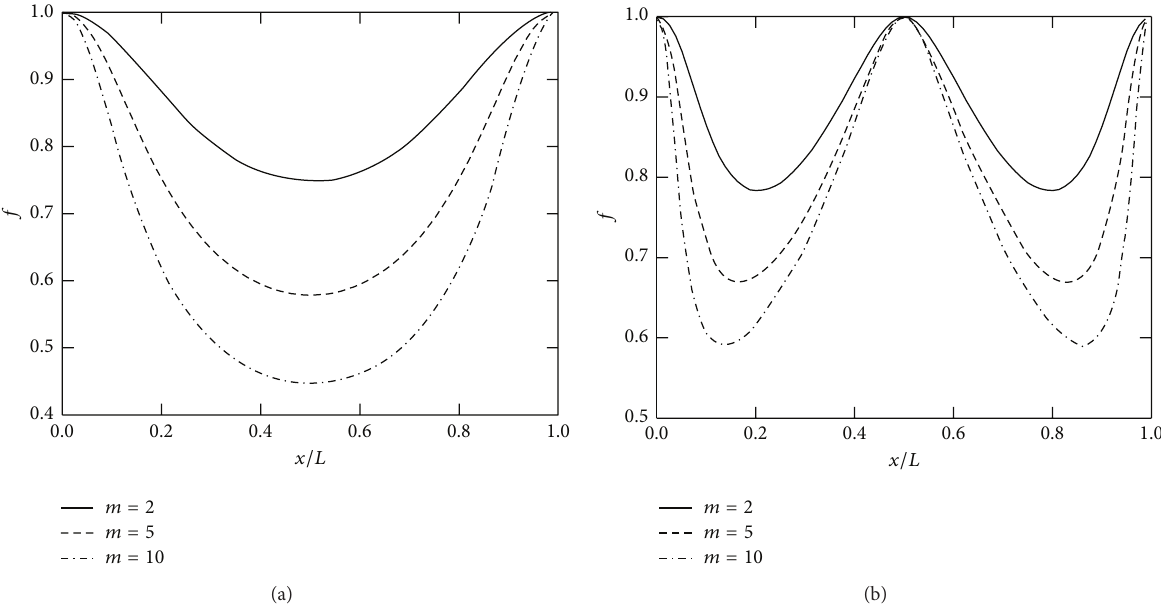
Figure 7: The first two normalized natural frequencies of simple-simple Timoshenko beam subjected to a moving mass with different masses.